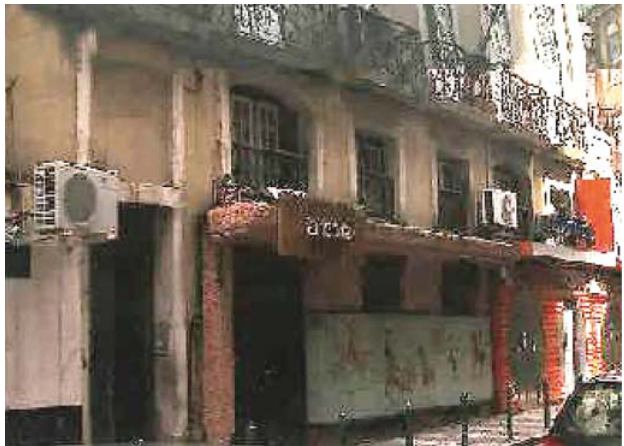
Figure 2. Condition of a building